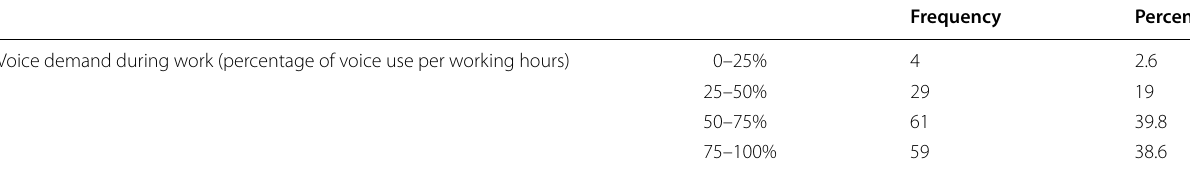
Voice demand during work (percentage of voice use per working hours)